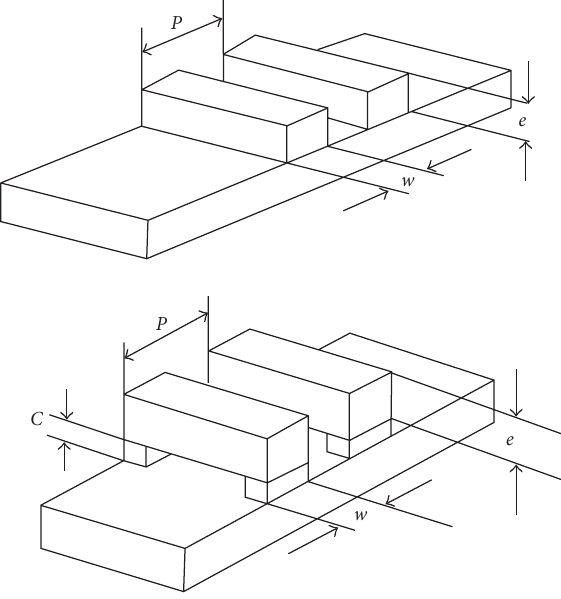
Figure 2: Figure showing the attached and detached rib arrange-